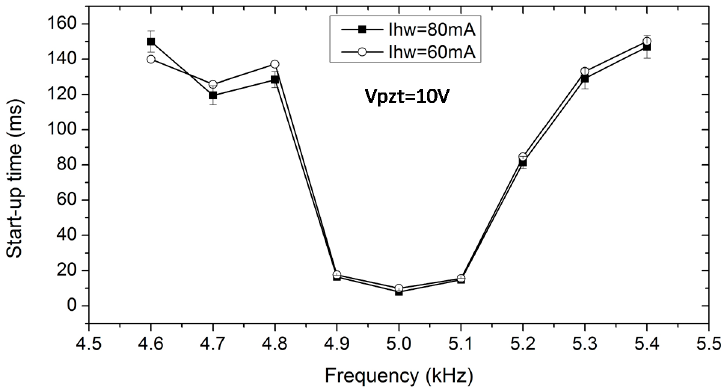
Figure 12. Relation of start-up time versus driving frequency on the PZT diaphragm.